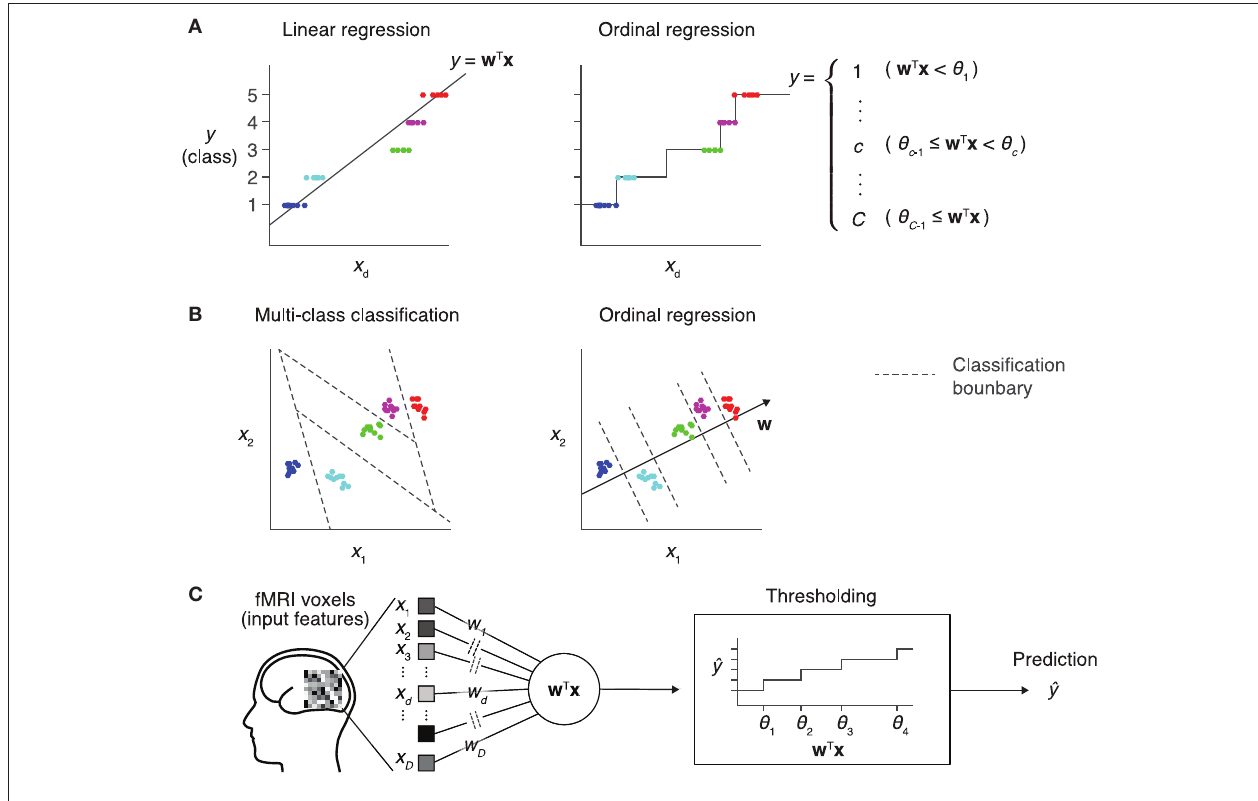
FIGURE 1 | Prediction models for an ordinal dependent variable. (A) Comparison between linear regression and ordinal regression. In linear regression, the prediction is calculated as a linear combination of input features. Here, y is assumed to be an ordinal variable and it takes one of five levels. The regression line on a single input dimension ( x d ) is shown (left). In ordinal regression, a linear combination is used for prediction, but not directly treated as its prediction. Thresholds that divide the real number line into five disjoint segments are introduced as parameters. Each segment corresponds to one of the five levels, and the prediction is obtained as the level corresponding to the segment that the linear combination value belongs to (right). (B) Comparison between multiclass classification and ordinal regression. In prediction with a multiclass classification model, classification boundaries that separate different classes are learned in the feature space (left). In ordinal regression, classification boundaries are restricted to be orthogonal to one single vector, which reduces the degree of freedom compared with typical classification models (right). (C) Sparse ordinal logistic regression (SOLR). A standard ordinal regression model, the ordinal logistic regression model, is combined with a Bayesian sparse parameter estimation method, and is introduced into fMRI decoding analysis in the present study. By estimating a subset of weight parameters to be nonzero and the other weight parameters to be zero, this method simultaneously selects important input features (voxels) and estimates the weight parameters. In prediction, it linearly combines voxel values with the estimated sparse weight vector, then outputs one of the given levels by comparing the resultant value with